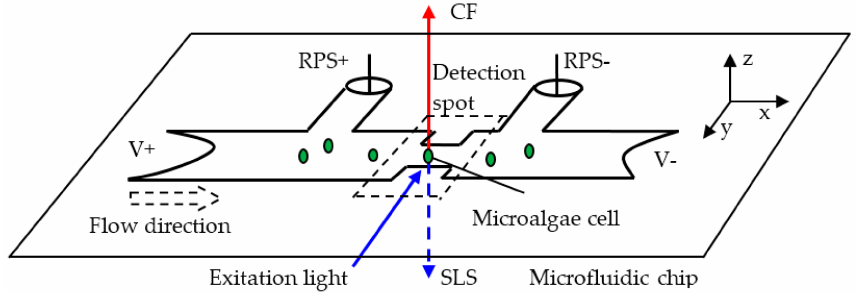
Figure 7. Schematic representation of the operation principle of single microalgae cell classification. The system is based on the simultaneous detection of chlorophyll fluorescence (CF), side light scattering (SLS) and resistance pulse sensing (RPS) signals. Reprinted with permission from [104]. Copyright 2016,